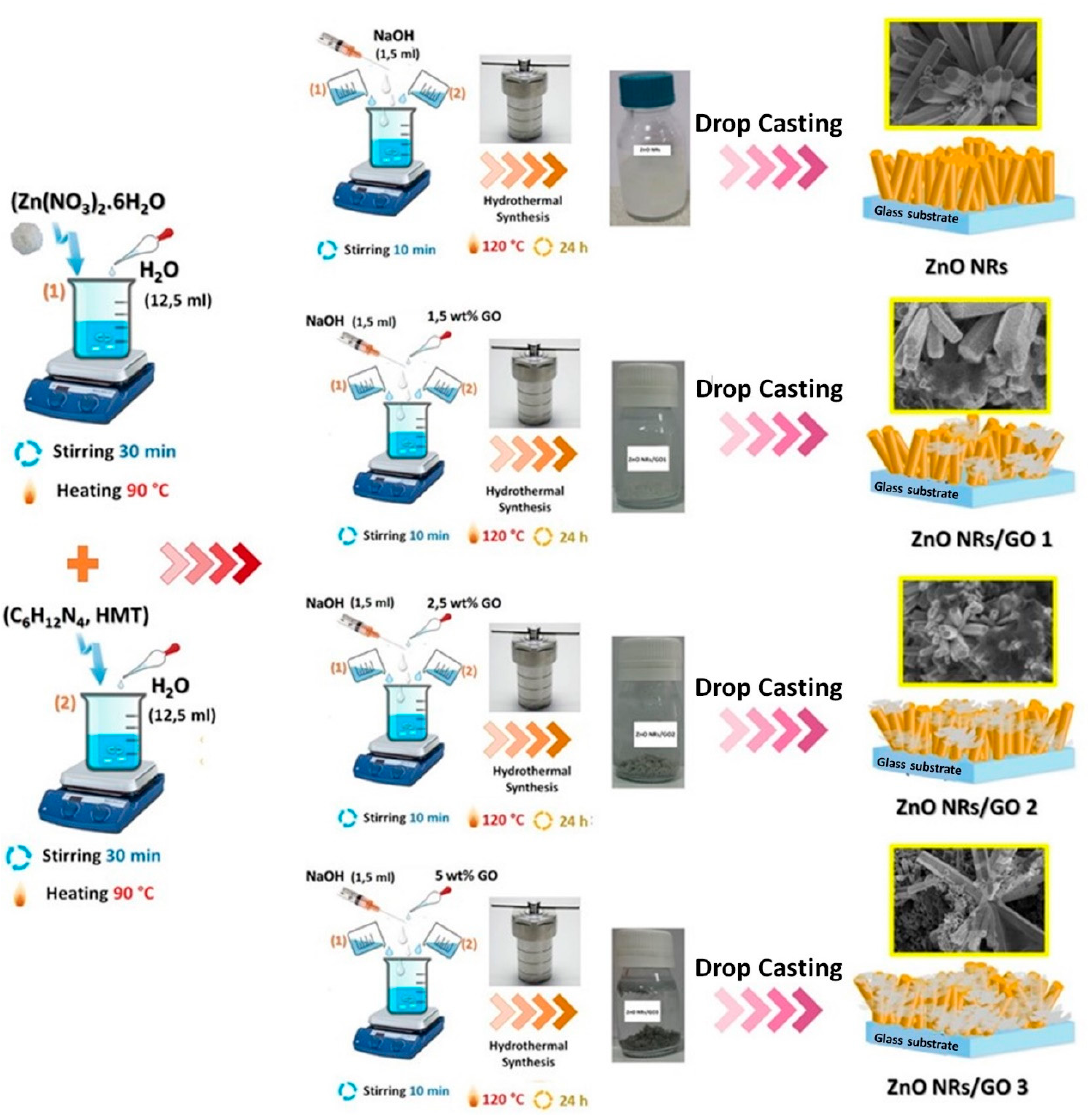
Figure 1. Preparation process of zinc oxide nanorods (ZnO NRs)/graphene oxide (GO) nanocomposites.